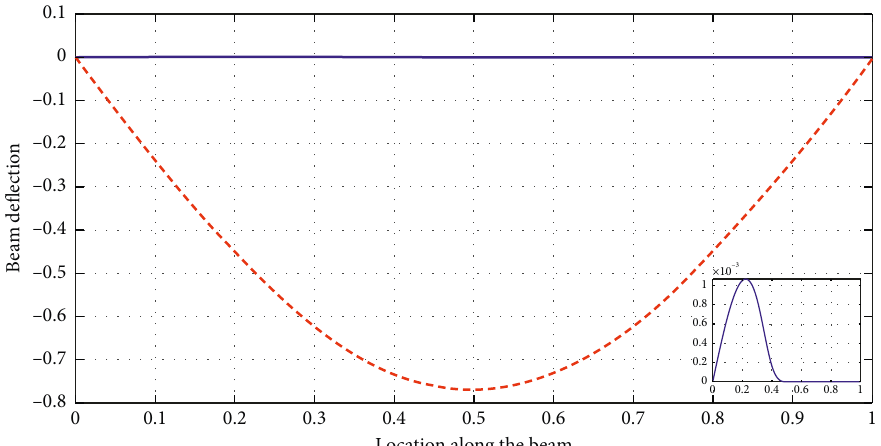
Figure 15: The steady-state deformed shape of a noncollocated controlled (solid line) and uncontrolled (dashed line) undamped simply supported beam when ω � 10, x f � 0.5, x n � 0.5, x shape.